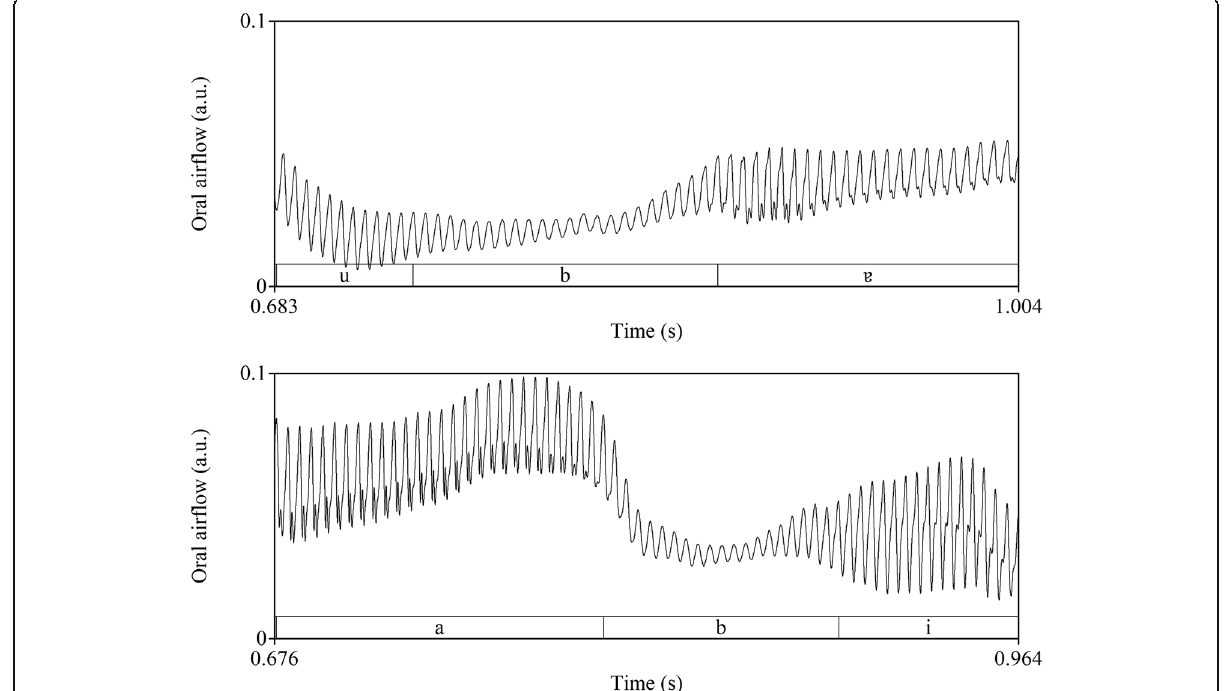
Fig. 3 Oral airflow waveform of two SP3 ’ s productions of strong voiced [b] (top) and weakly voiced [b]